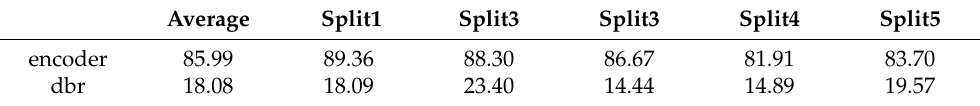
Table 2. Presented here are the results for the encoder as precision compared with the Dynamsoft Barcode Reader for DPM on SLS-manufactured parts for the five different test splits and as average values. With an average of 85.99%, the encoder is able to transform images into readable data matrix code. As the DBR is not deployed for SLS DPM, an average of 18.08 indicates that a comparison is not